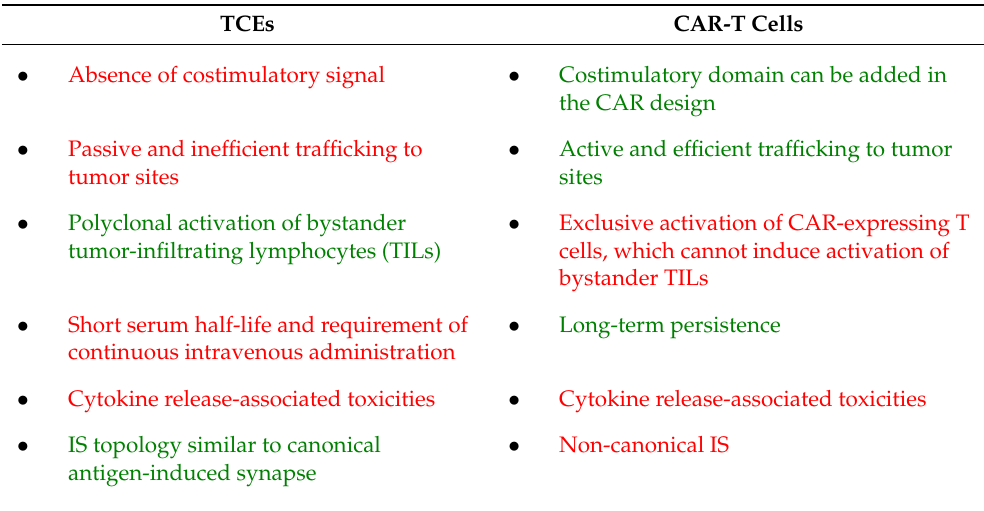
Table 2. PROS (green) and CONS (red) of TCE- and CAR-T cell-based therapies. TCEs CAR-T